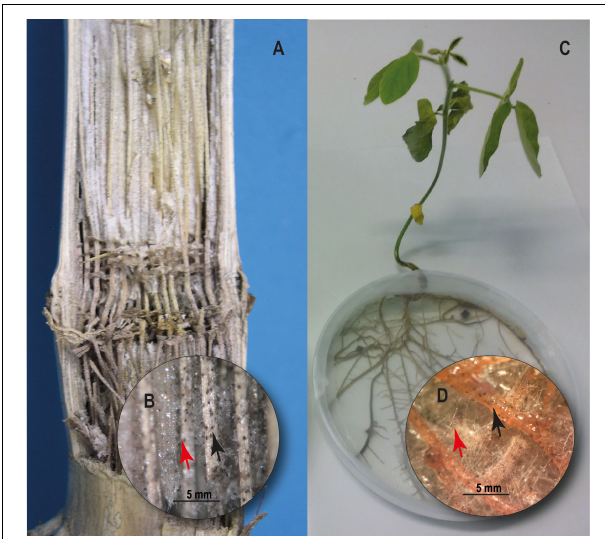
FIGURE 2 | Charcoal rot on corn ( Zea mays L.) and soybean ( Glycine max ). (A) Inside of corn stem showing black discoloration and shredding of vascular bundles. (B) M. phaseolina hyphae (red arrow) and microsclerotia developed on vascular aces of corn stem (black arrow). (C) Soybean plant 10 days post inoculation with M. phaseolina under in vitro culture conditions. (D) M. phaseolina hyphae (red arrow) and microsclerotia developed on soybean roots (black arrow).